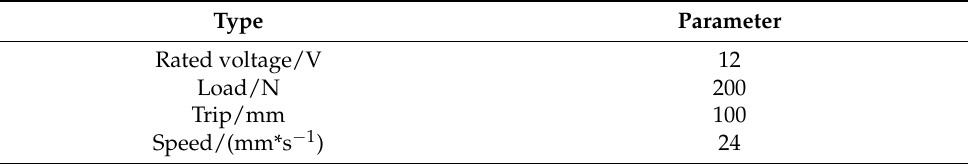
Figure 3. Installation schematic diagram of the electric push rod. ( a ) Structure diagram; ( b ) installation drawing: 1. Accelerator pedal; 2. Linear actuator; 3. Support plate; 4. Transplanter chassis; 5. Steel strand core; 6. Stay sleeve. Table 3. Parameters of the electric push